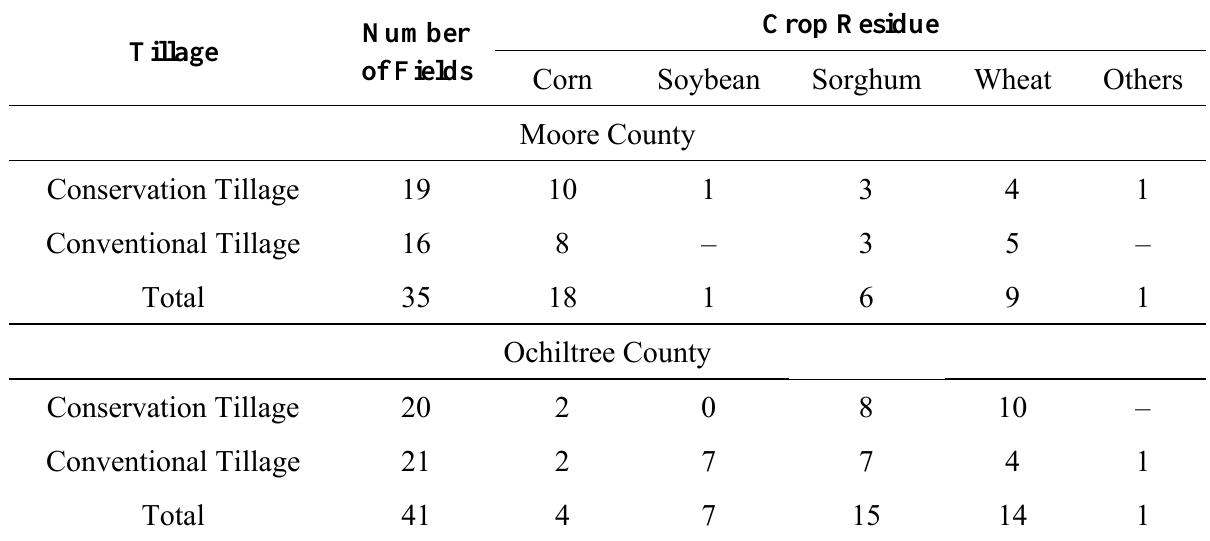
Table 1. Tillage and crop residue characteristics of randomly selected commercial fields for ground truth data from Moore and Ochiltree Counties, Texas during the 2005 pre-planting season.